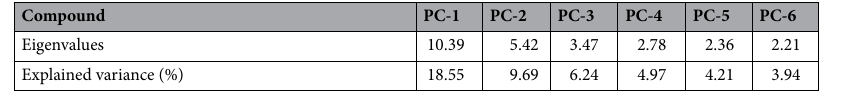
Table 2. Principal components analysis (PCA) for relative proportions of compounds found in feces of Iberian wolves ( Canis lupus signatus ). Correlations between variables (compounds) and the principal components significant at P < 0.00001 are marked in bold.